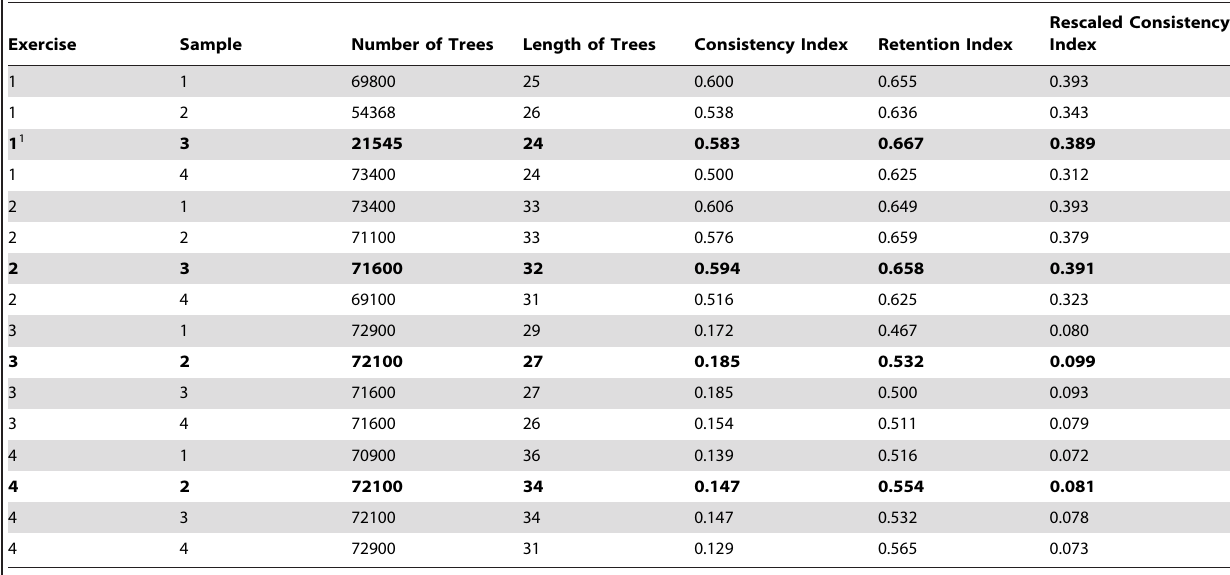
Table 6. Parsimony heuristic search scores.